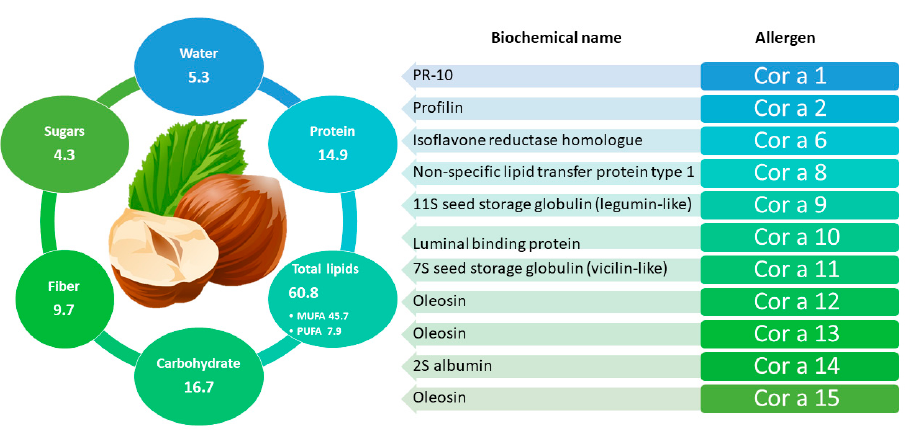
Figure 3. ( Left ) relevant information on the nutritional composition (g/100 g) relating to the Corylus avellana species. ( Right ) list of allergenic proteins identified and registered to date on the WHO/IUIS online allergen nomenclature platform.